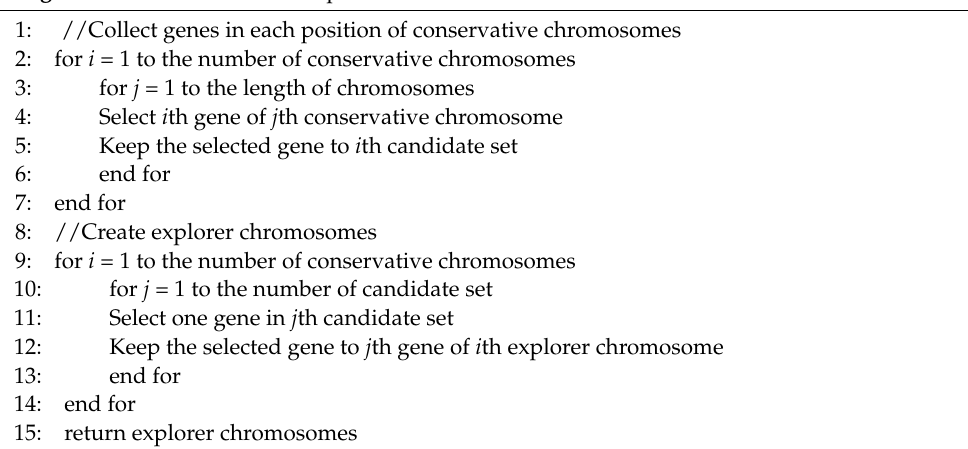
Algorithm 1 Pseudocode for explorer